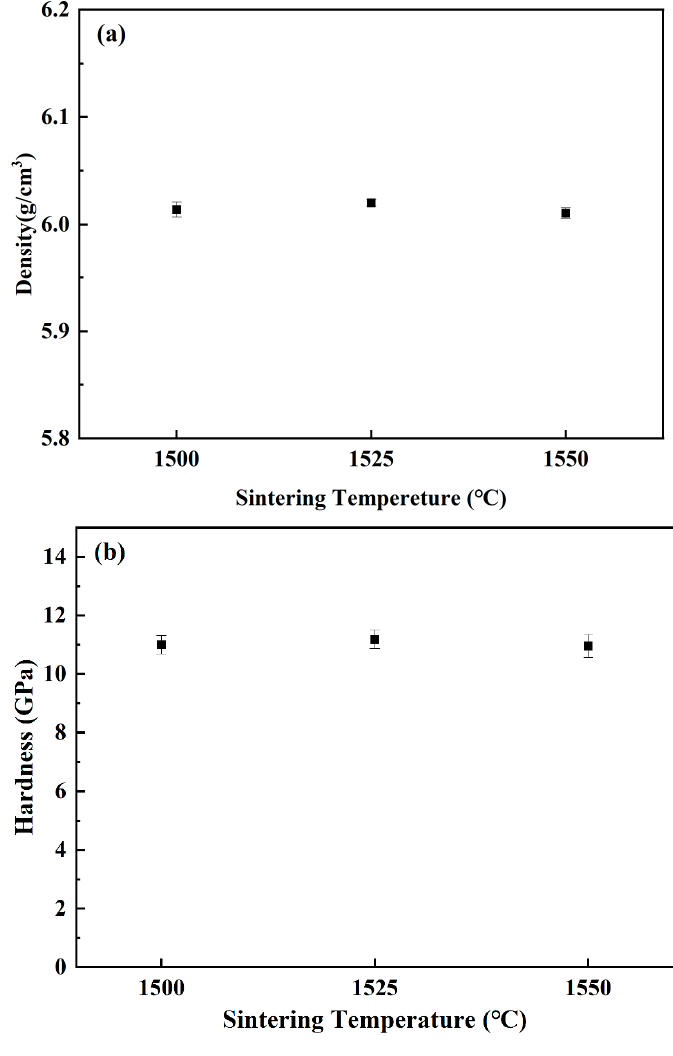
Figure 11. Densities ( a ) and hardness ( b ) of sample A sintered at different temperatures for 2 h.